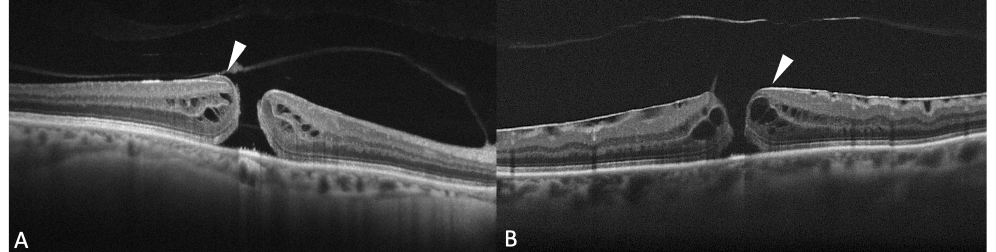
Figure 5. ( A ) Optical coherence tomography (OCT) scan showing a full-thickness macular hole (FTMH) accompanied by atypical epiretinal tissue (arrowhead); ( B ) OCT scans showing a hyperreflective epiretinal membrane associated with FTMH (arrowhead).